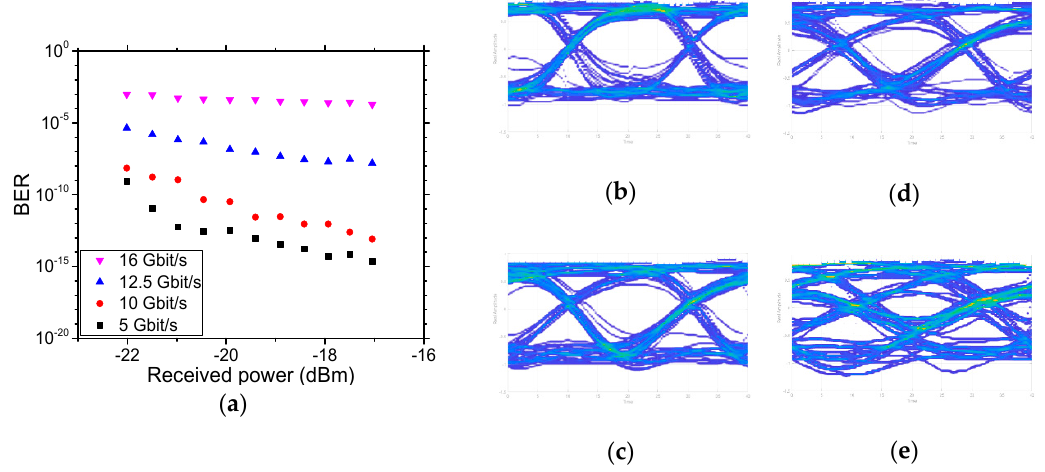
Figure 20. The dependence of BER on the received optical power ( a ), and eye diagrams for 5 ( b ), 10 ( c ), 12.5 ( d ), and 16 ( e ) GHz for a 23 µm in diameter microdisk laser at 30 °C.